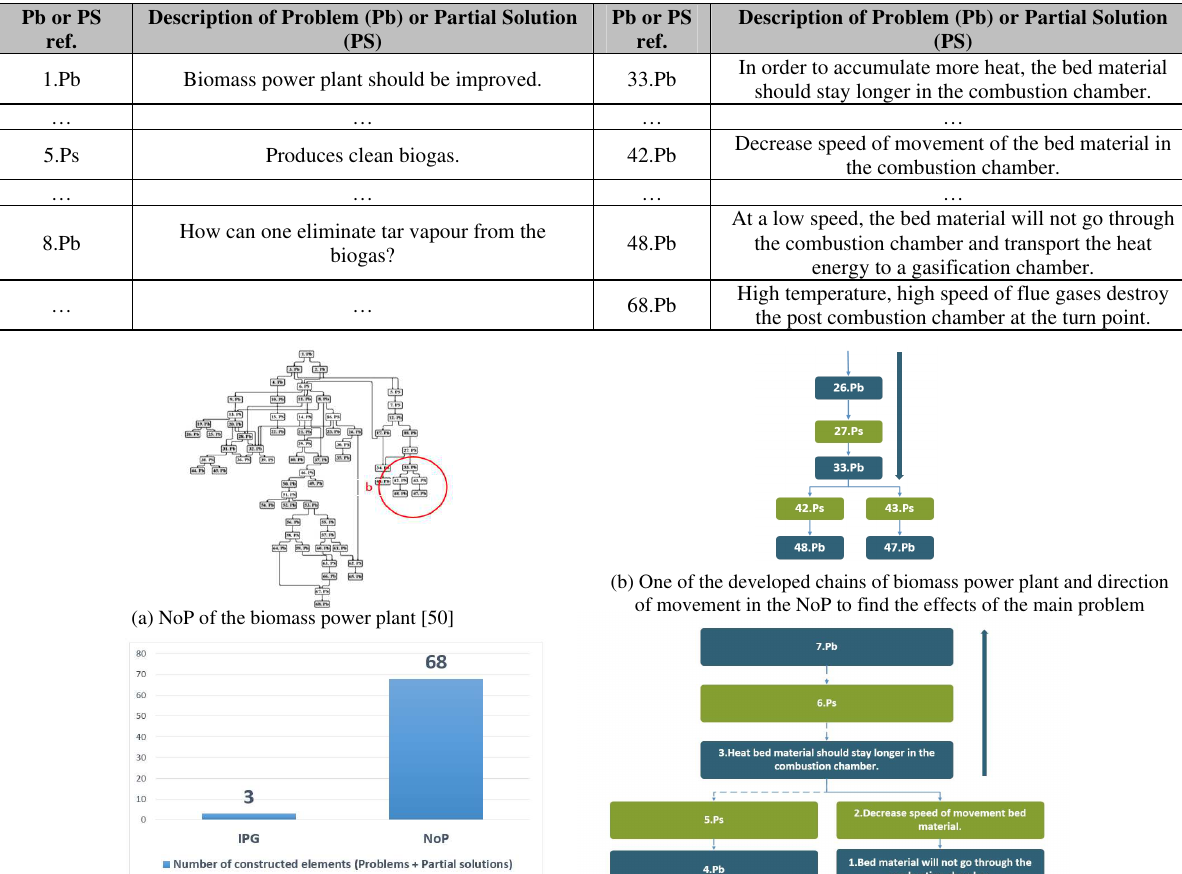
(d) Number of constructed elements by applying IPG and Figure 15. Network of Problem and its difference with the Inverse Problem Graph [50]